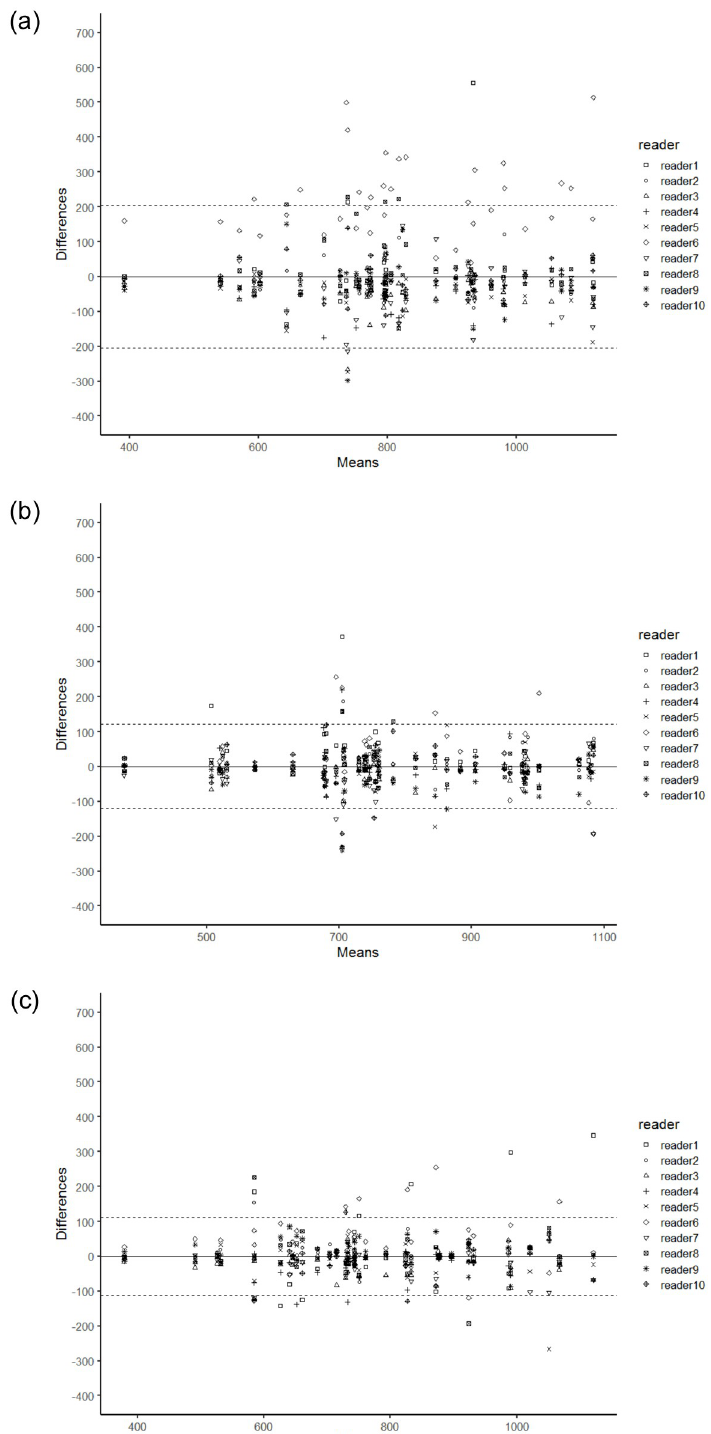
Fig 3. Bland-Altman plots of ADC values in each measurement method. (a), Free 2D-small-ROI method. (b) 2D- small-ROI method with specific instruction to use 9-pixel 2D-small-ROI covering the lowest ADC area. (c) Tenth percentile of 3D-whole-lesion-ROI method. The x-axis is the average ADC value, whereas the y-axis is the difference between ADC value by each reader and the average ADC value. The 95% limits of agreement were ± 205 (10 − 6 mm 2 /s) for the free 2D-small-ROI method, ± 120 (10 − 6 mm 2 /s) for the 2D-small-ROI method with specific instruction, and ± 112 (10 − 6 mm 2 /s) for 10th percentile of 3D-whole-lesion-ROI. ADC indicates apparent diffusion coefficient; ROI, region of interest; 2D, two-dimensional; 3D, 3-dimensional. https://doi.org/10.1371/journal.pone.0268829.g003 PLOS ONE | https://doi.org/10.1371/journal.pone.0268829 May 23,